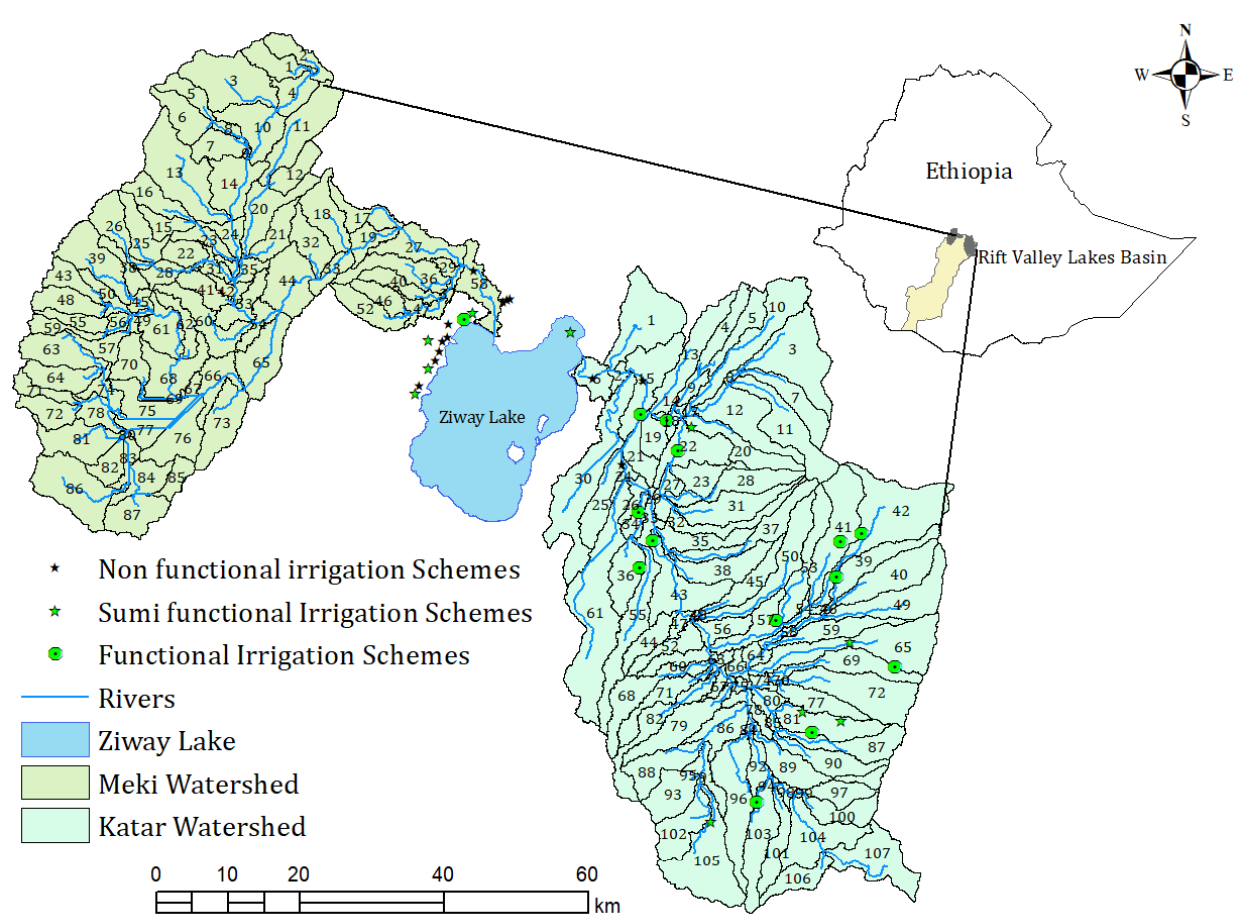
Figure 1. Location map of the study area and irrigation schemes.